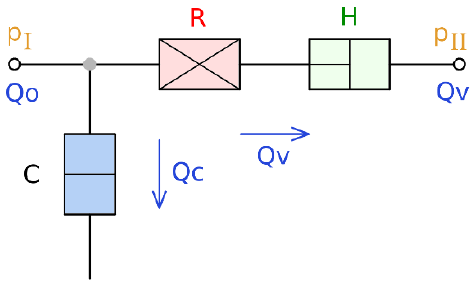
Fig. 1. Electric analogy, L - segment